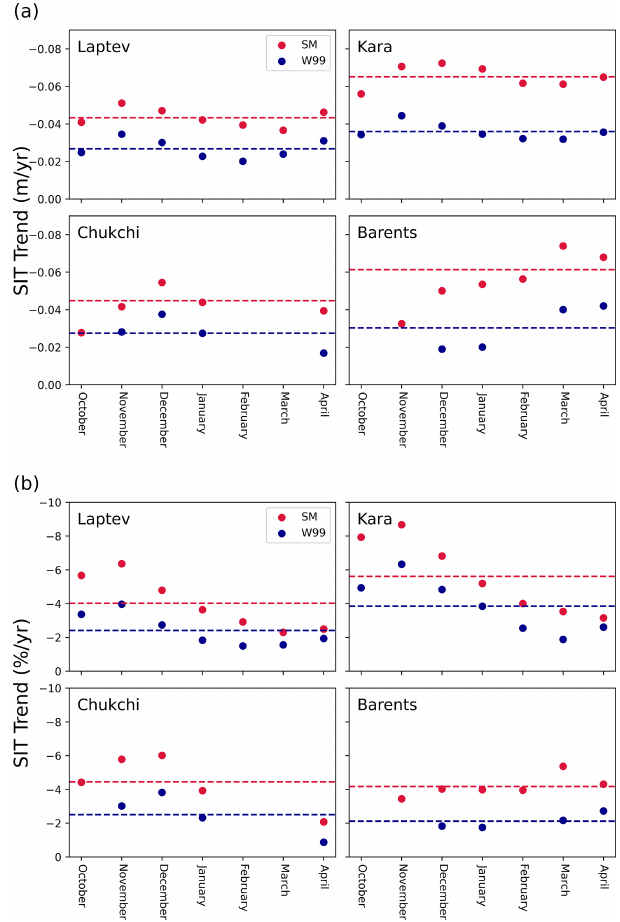
Figure 11. Sea ice thickness trends in the four marginal seas that exhibited robust trends in several winter months in the period 2002– 2018. Average winter trend (calculated only from statistically sig- nificant months) from each snow product shown with dashed lines. Data points are only shown where a statistically significant trend is present for that month and for the relevant snow